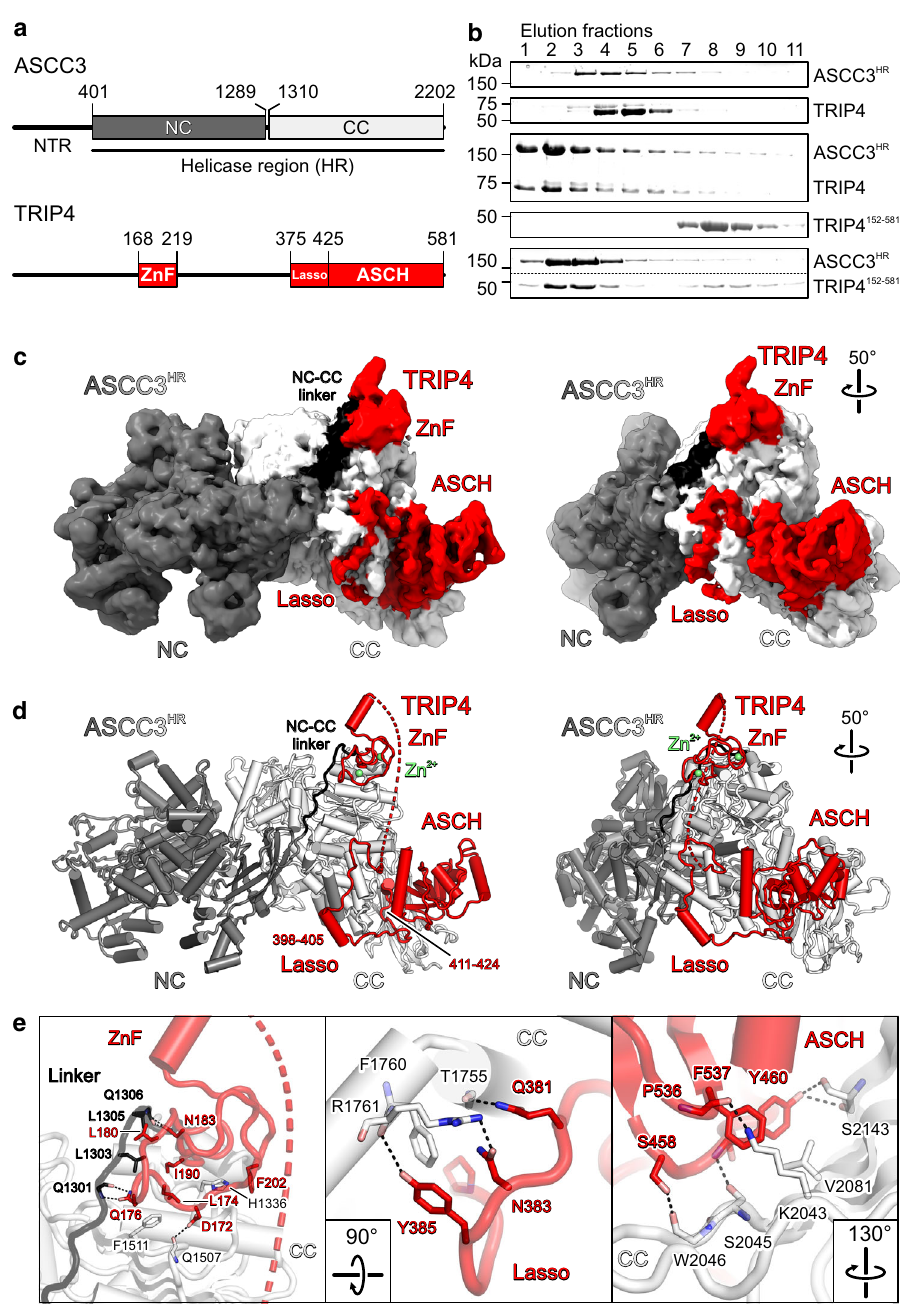
Fig.1|StructureofaASCC3 HR – TRIP4complex.a Schemesofregionsordomains in ASCC3 and TRIP4. Numbers above the schemes, region/domain borders. NTR N-terminalregion, NC/CCN-terminal/C-terminalcassettes, HRhelicaseregion, ZnF zinc fi nger domain, Lasso lasso peptide, ASCH ASC − 1 homology domain. b SDS- PAGE analyses of analytical SEC elution fractions monitoring the interaction of ASCC3 HR with selected TRIP4 variants. Equivalent elution fractions are vertically aligned. Molecular mass markers in kDa are shown on the left; protein bands are identi fi ed on the right. In the bottom panel, separate regions of the same gel were spliced together for display purposes (see Source Data fi le for uncropped gel). Dashed line, splice line. Experiments were repeated independently at least three timeswithsimilarresults. c OverviewofthecryoEMreconstructionoftheASCC3 HR -